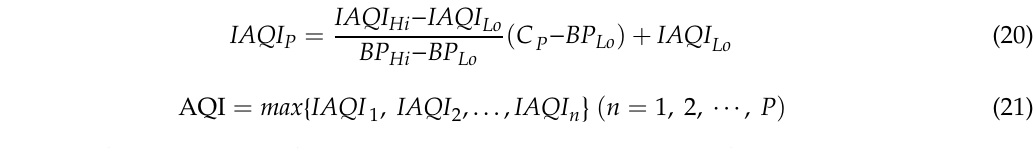
Figure 8. Time distribution characteristics of O 3 concentration, ( a ) in case one, ( b ) in case